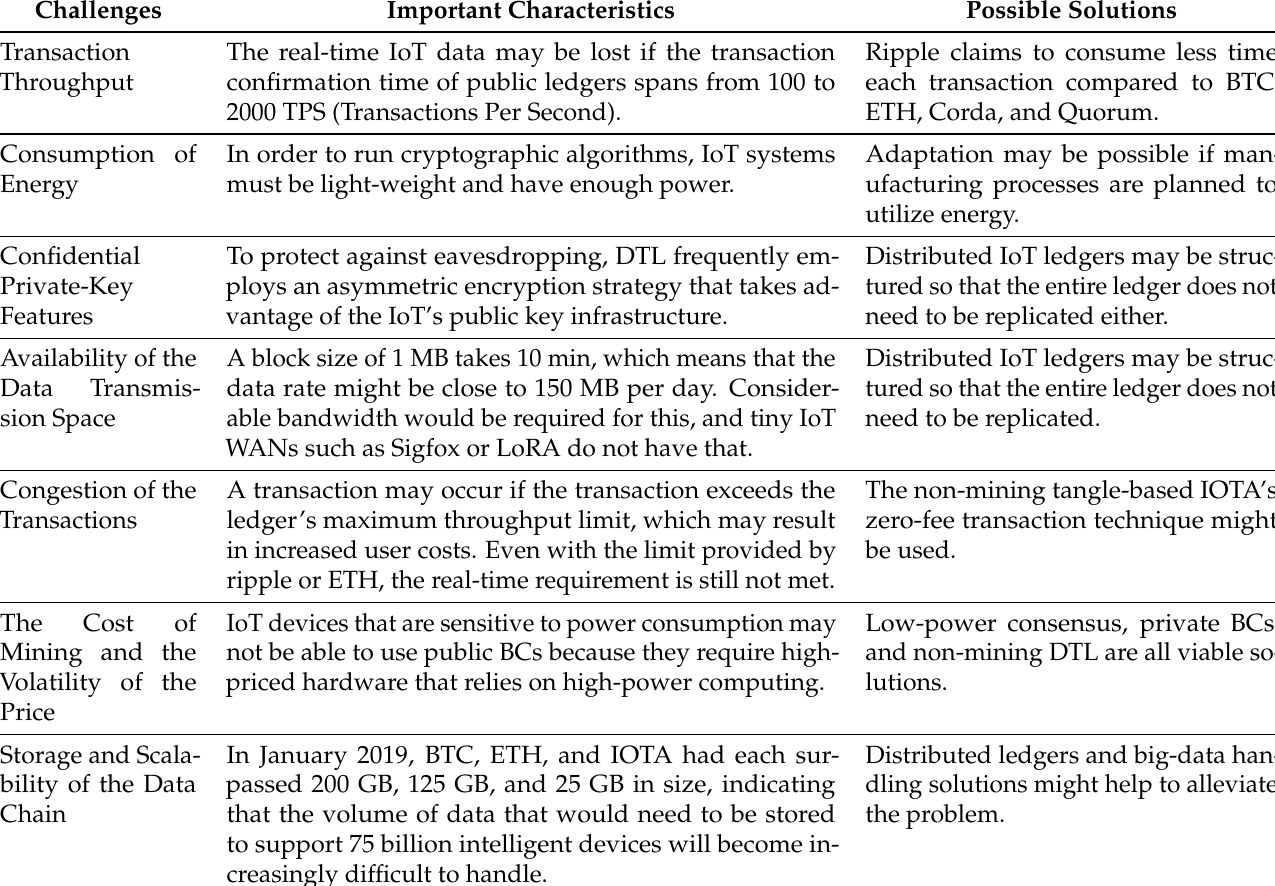
Table 3. BC-IoT Implementation Challenges, Important Characteristics, and Possible